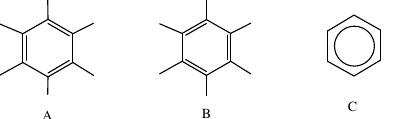
Figure 10. Arrangement of electrons in methyl